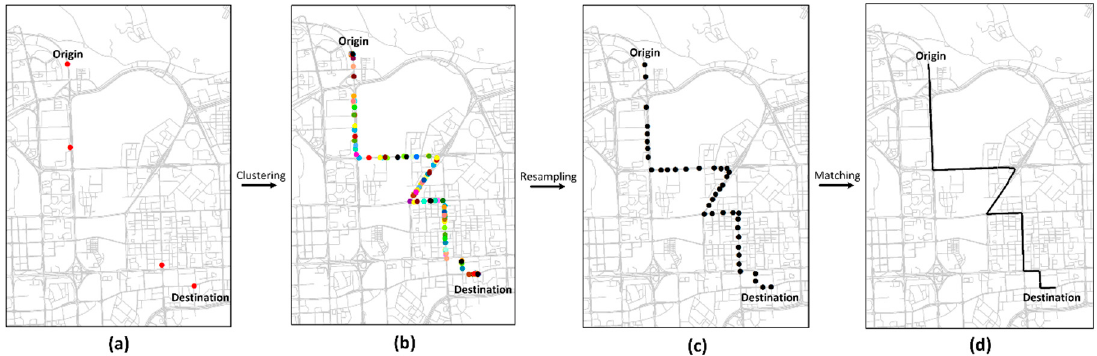
Figure 15. Visualization of map matching for a simulated low-sampling-rate GPS trajectory. ( a ) Low-sampling rate GPS trajectory. ( b ) Trajectory cluster. ( c ) Collaborative trajectory. ( d ) Map matching result.